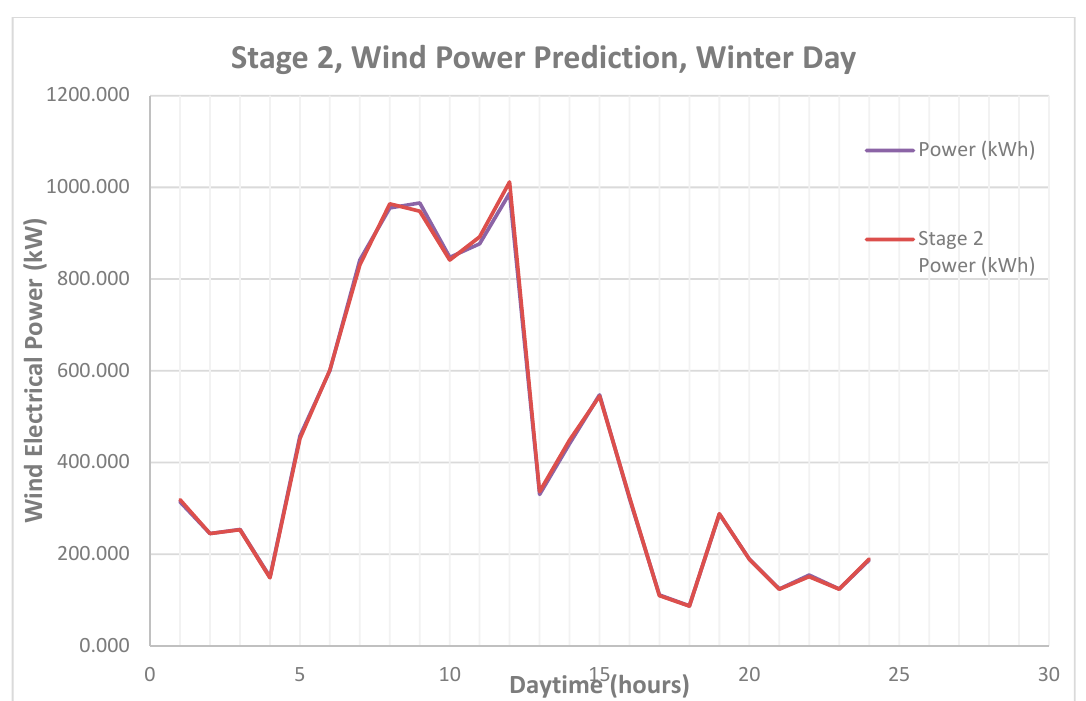
Figure 10. Wind Electrical Power forecasting results from Stage 2, Winter Day.